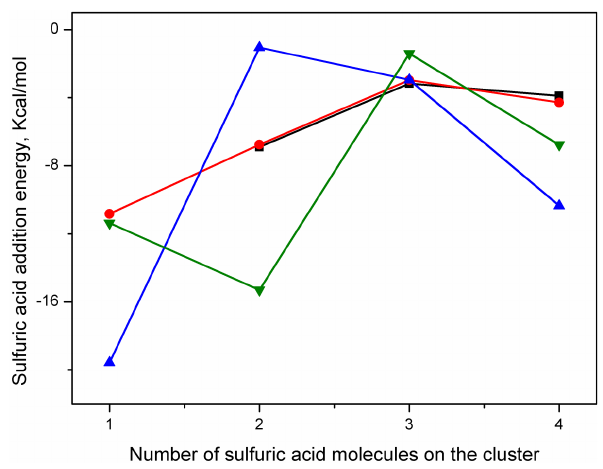
Fig. 9. Upper plot: modelled (solid lines) and measured (dashed lines) total particle number concentrations for particles with a di- ameter > 20nm for in the Set 1 experiments. Lower plot: modelled sulphuric acid concentrations in the same Set 1